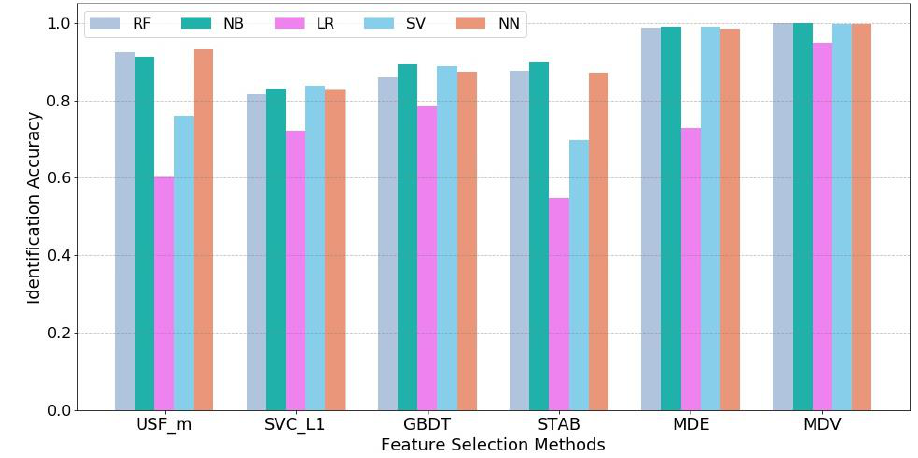
selection methods instead of obtaining the optimized parameter setting for each machine learning